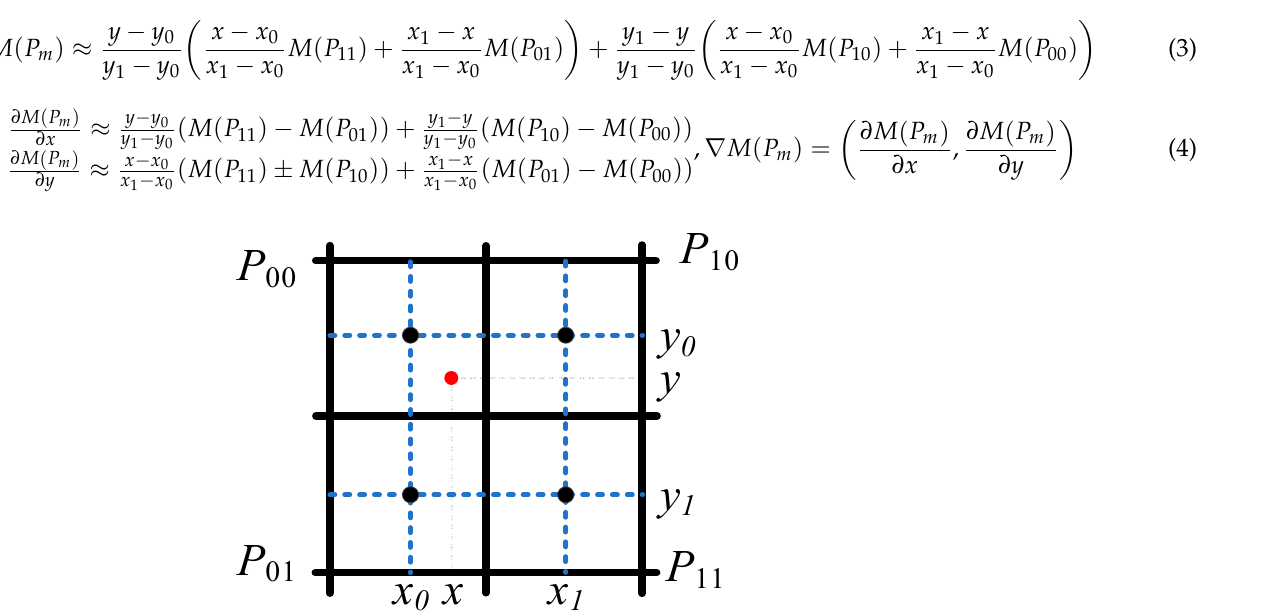
Figure 4. Schematic diagram of the bilinear interpolation.